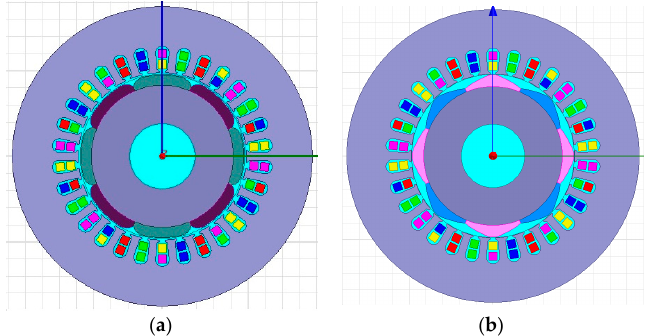
Figure 9. Maxwell model of two FPMSMs: ( a ) THI − FPMSM; ( b ) SIN − FPMSM.